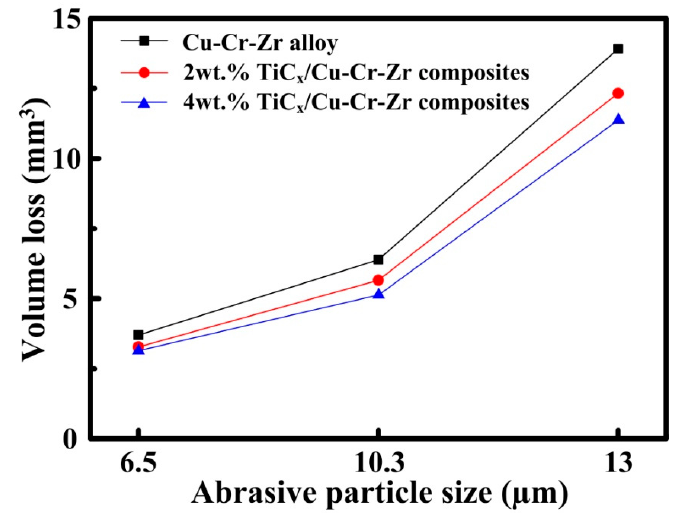
Figure 6. Volume loss against different abrasive particles of 6.5 μ m, 10.3 μ m and 13 μ m at the applied load of 5N for the Cu–Cr–Zr alloys and nano-sized TiCp-reinforced Cu–Cr–Zr composites.